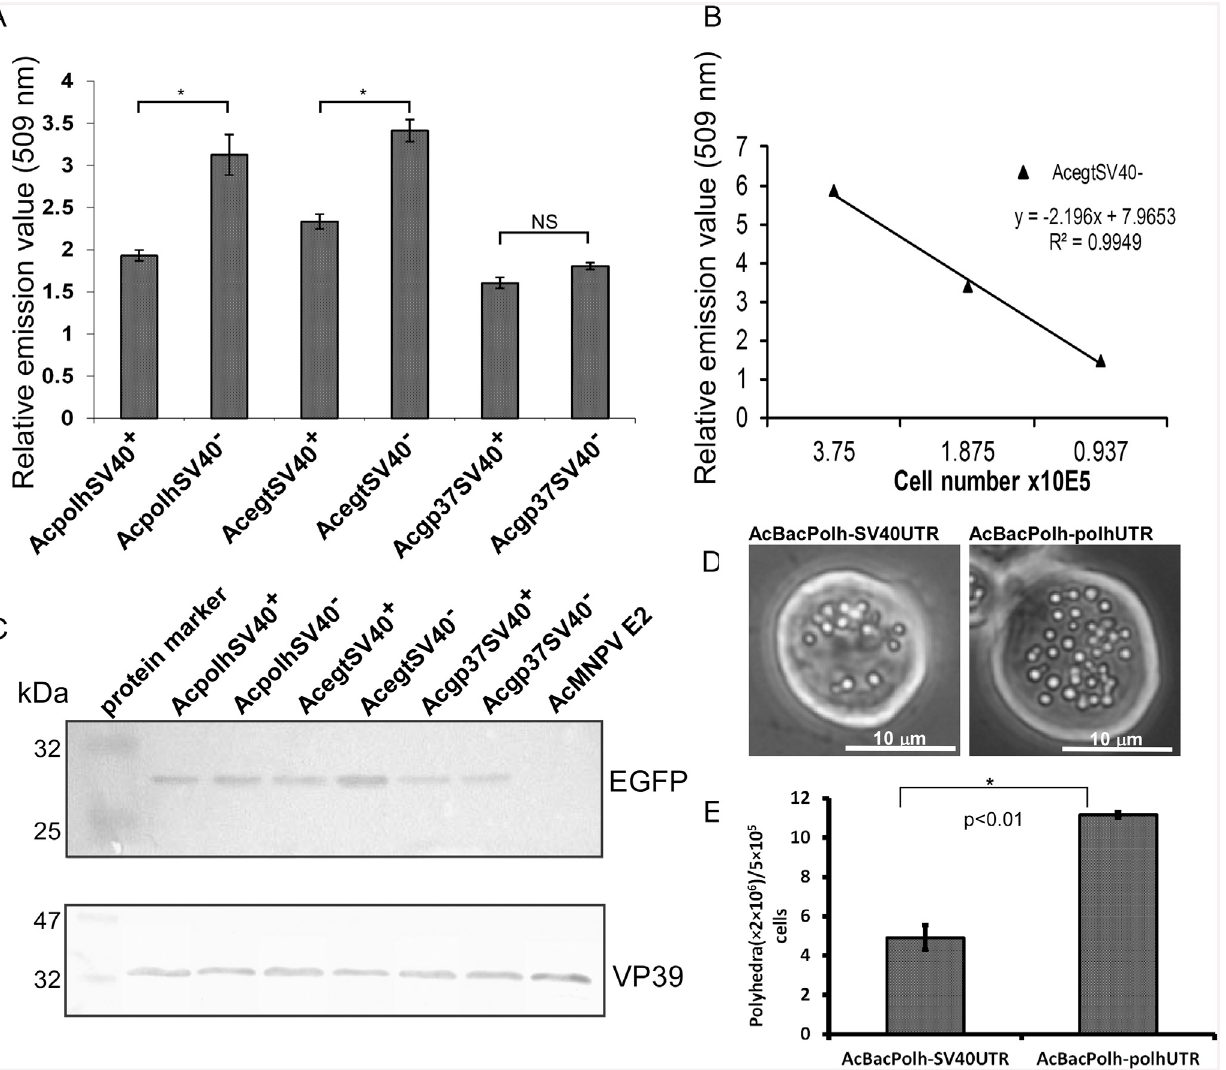
Fig 2. EGFP expression yield comparison of Sf21 cells infected with viral constructs with or without the SV40 polyA signal at the polh, egt and gp37 loci of the AcMNPV genome. A . Quantitative analysis of EGFP yields to test the effects of SV40 polyA on EGFP expression in the baculovirus expression vector system. Sf21 cells were infected by different viral constructs at an m. o. i. of 10 p.f.u./cell and the cells were harvested at 48 h post infection for fluorescence emission measurement in three independent cell infections. * indicates significant difference at P = 0.05. NS, not significant. Error bars denote SD. B . Validation of the fluorescence measurement to ascertain fluorescence values falling in the linear range. EGFP produced by the Sf21 cells infected by AcegtSV40 - were diluted and fluorescence emission values were plotted against the number of cells. C . Western blotting analysis of EGFP yields by viral constructs with or without the SV40 polyA signal. Equal amounts of total proteins from Sf21 cells infected with viruses were used for SDS-PAGE. The separated proteins from the gel were transferred onto a nitrocellulose membrane and probed with an anti-GFP antibody to detect the amounts of EGFP production from different viral infections. A separate membrane identical to that for the EGFP detection was probed with an anti-VP39 antibody. D . Comparison of polyhedra production of Sf21 cells infected with either AcBacPolh-SV40UTR or AcBacPolh-PolhUTR. E . Quantitative comparison of polyhedra production of Sf21 cells infected with either AcBacPolh-SV40UTR or AcBacPolh-PolhUTR. * indicates significant difference at P =